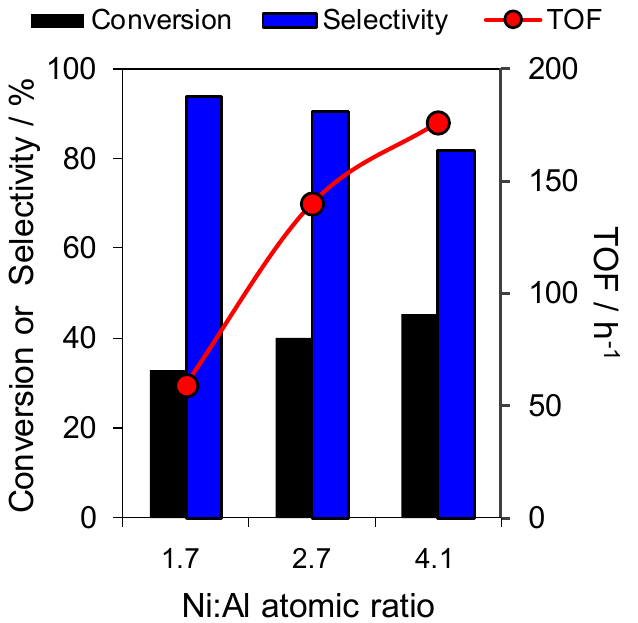
Figure 3. Activity of reconstructed NiAl LDH for transesterification of tributyrin with methanol as a function of NiAl ratio; conversion and selectivity after 24 h, TOF from initial rate over 1 h reaction. Reaction conditions: 100 mg catalyst, 110 °C, 10 mmol TAG, 30:1 methanol:TAG molar ratio, 650 rpm stirring.